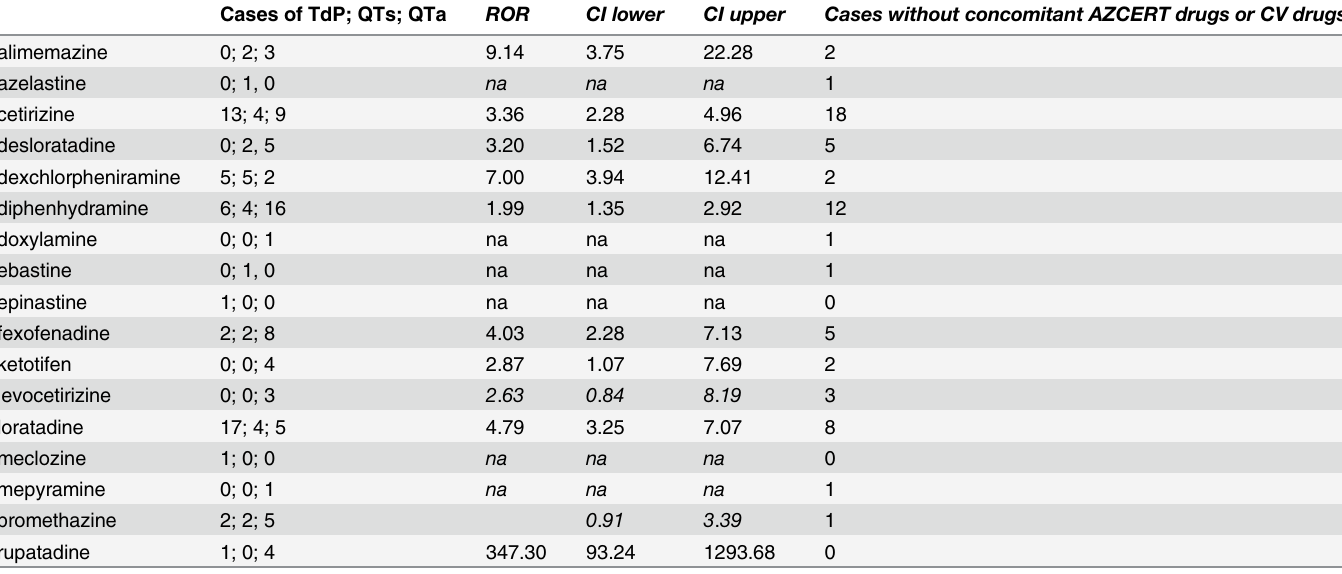
Table 1. Disproportionality analysis for antihistamines with cases of QT prolongation/TdP. Cases of TdP; QTs; QTa